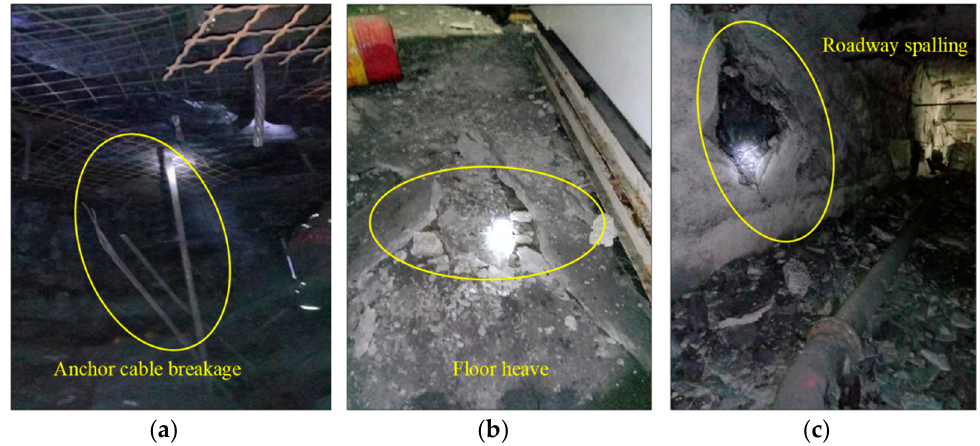
Figure 3. Roadway deformation and failure diagram. ( a ) Anchor cable breakage; ( b ) floor heave; ( c ) roadway spalling.